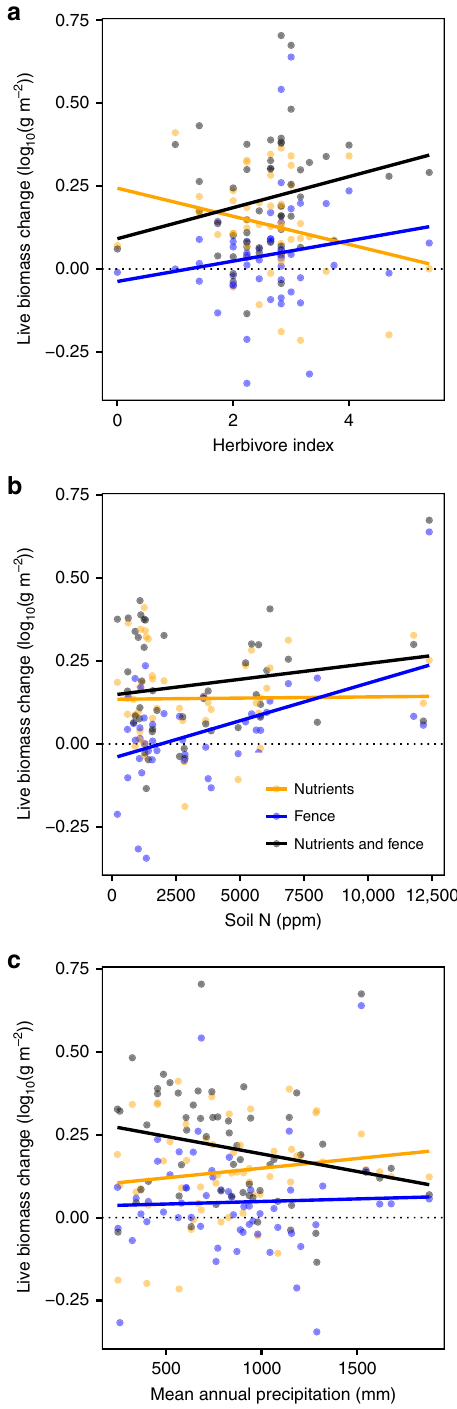
Fig. 3 Herbivore control of grassland biomass varies with the biotic and abiotic environment. Plots show the average site-level difference of each treatment from the unfertilized, unfenced control across a gradient of a herbivore impact intensity and frequency, b ambient soil nitrogen, and c mean annual precipitation. Gradients in panels a – c were identi fi ed from statistical models presented in Supplementary Tables 4a –